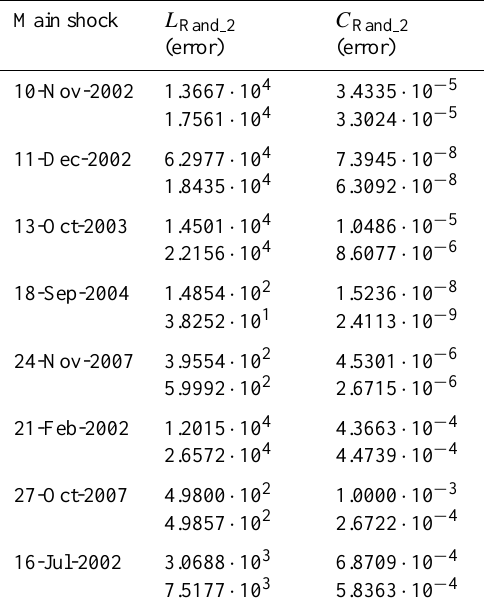
Table 5. Values of the average path length and clustering coefficient for the random networks calculated by shuffling the